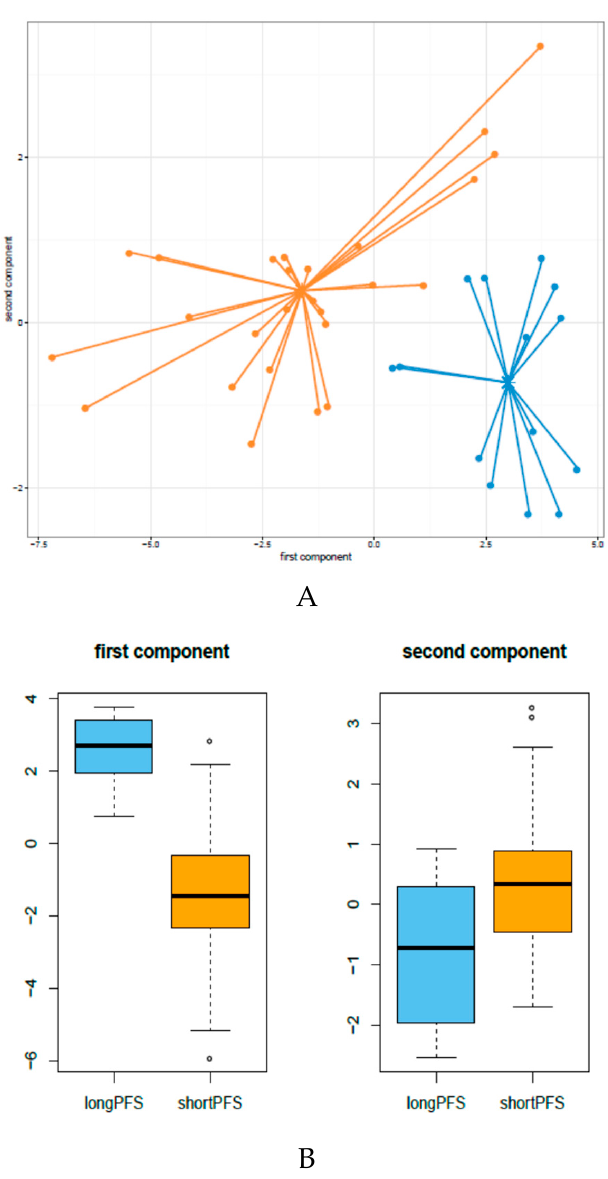
Figure 1. miRNA expression patterns in HNSCC tumors associated with PFS after cetuximab-CT treatment: sPLS-DA identified 24 and 12 miRNAs in first and second components, respectively (see Supplementary Materials Table S1 for list). ( A ) The score plot of sPLS-DA miRNA profiles of the two components is shown and each individual patient was plotted. The well-defined clusters, corresponding to the 14 long-PFS patients (blue dots) and the 26 short-PFS patients (orange dots), can be identified. The lines indicate the distance from the respective centroid for samples of each class; ( B ) The box-plot analysis shows the loading vector values for the first component and second component with samples divided on the basis of class (long PFS = blue; short PFS = orange). A significant difference was observed in each component (first component, p = 2.97E-07; second component, p = 0.00529).